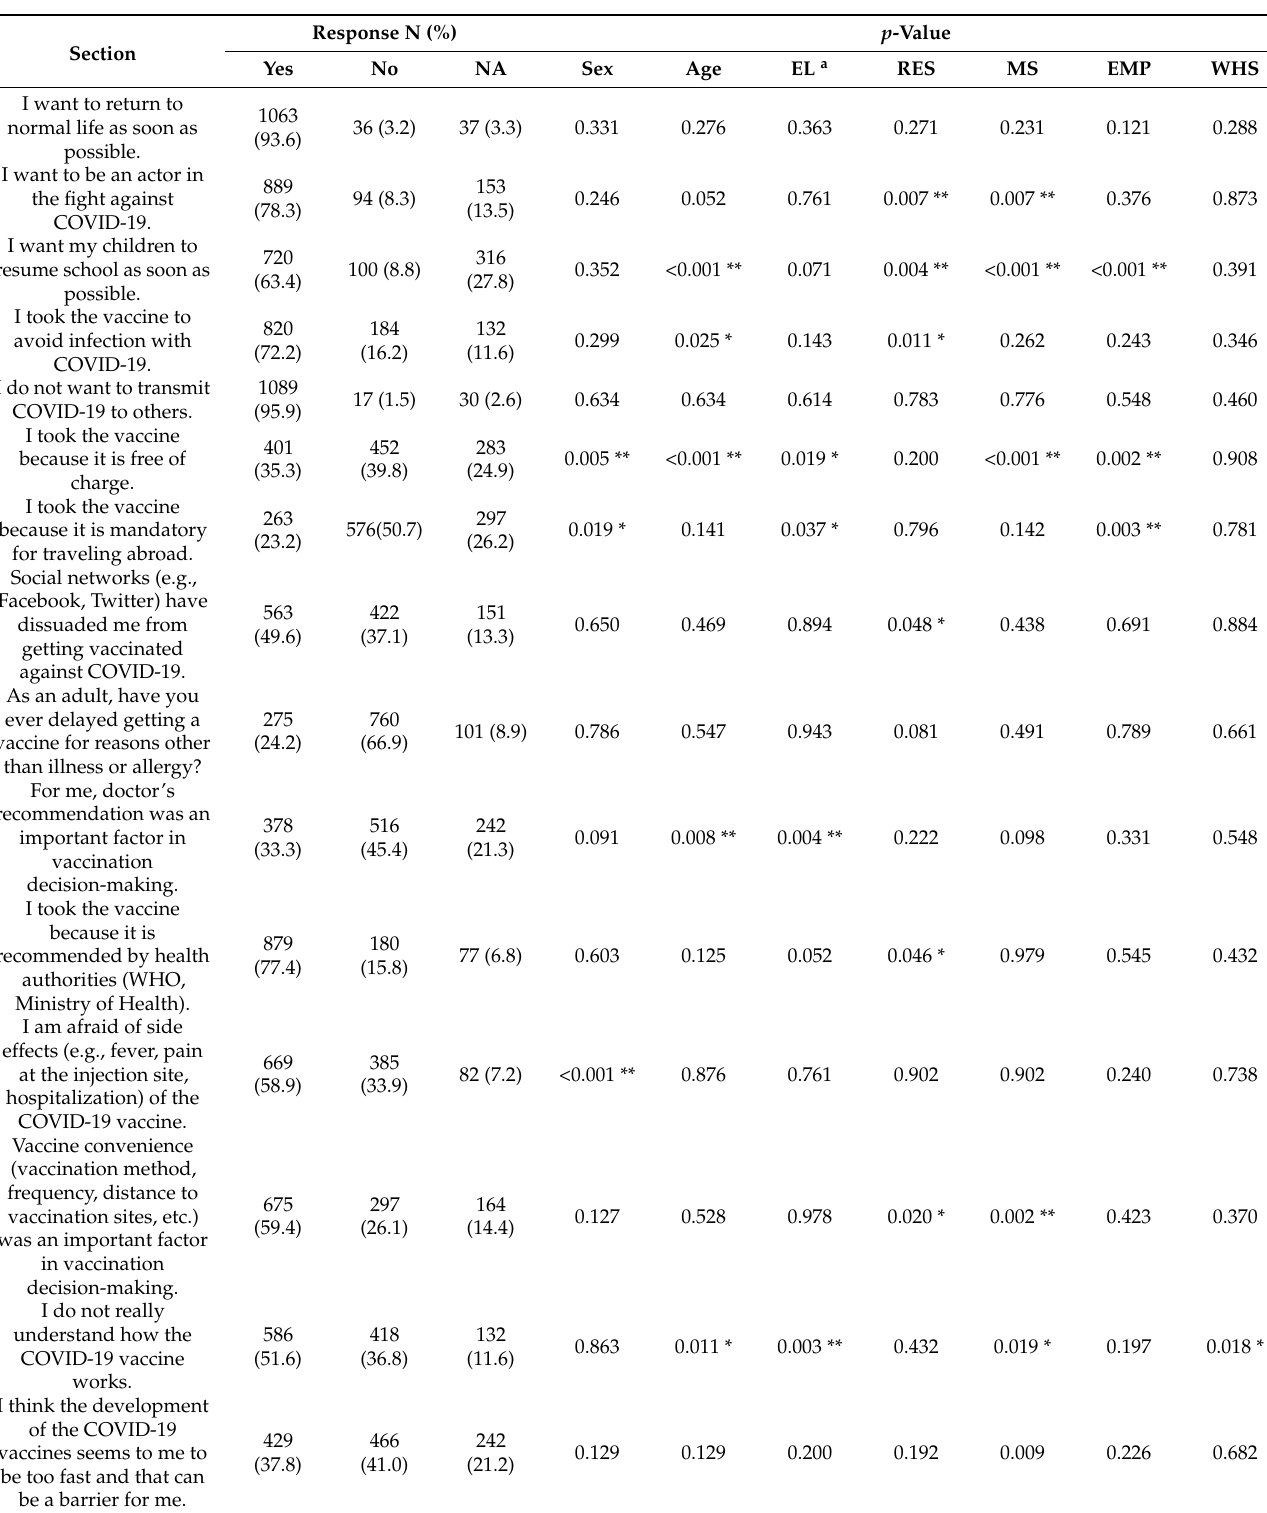
Table 3. Participants’ motivators and barriers about COVID-19 and its